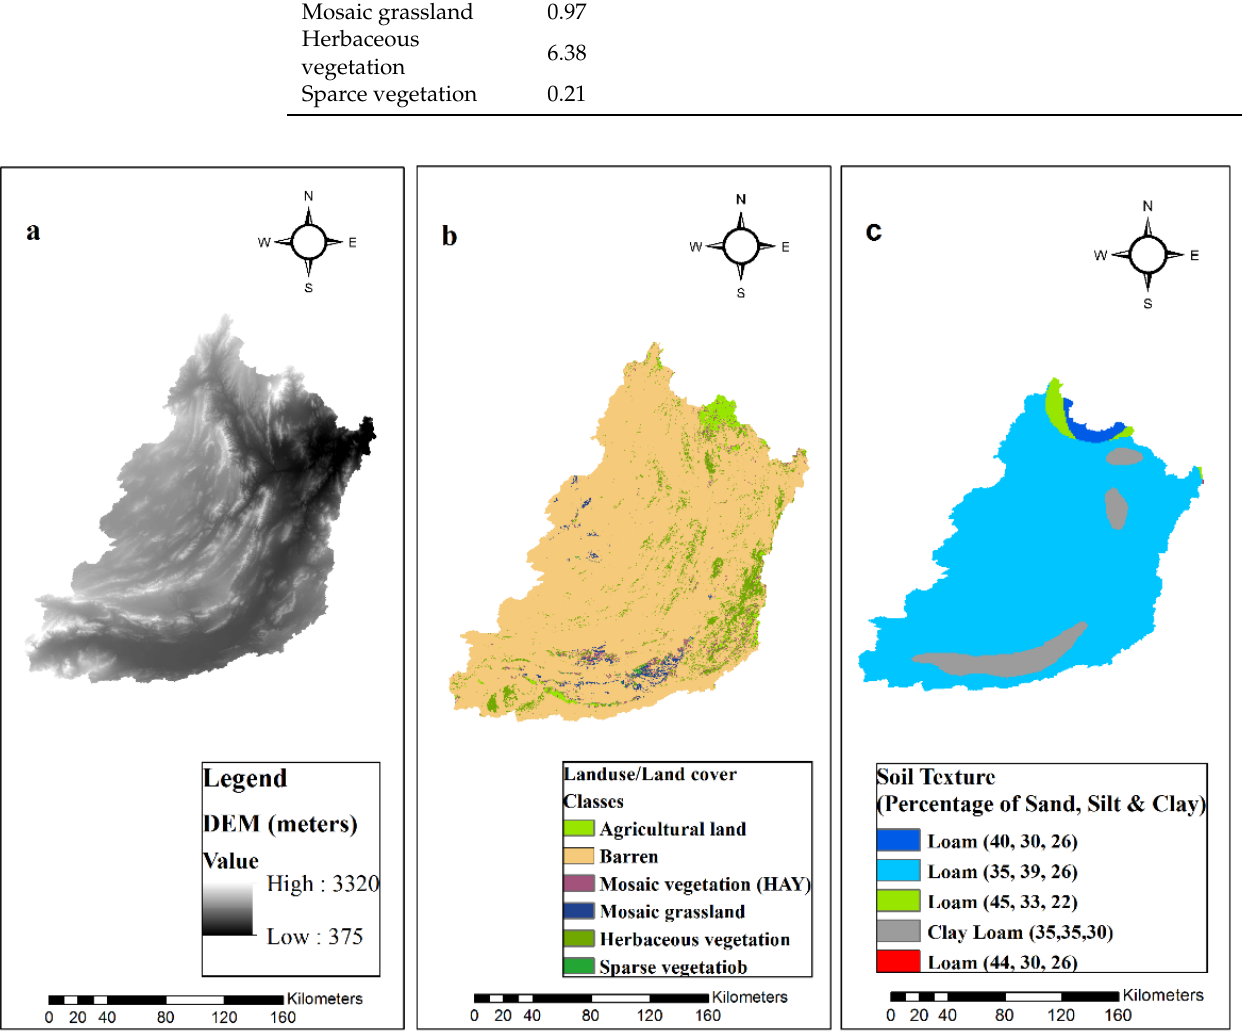
Figure 2. Spatial data inputs: ( a ) DEM, ( b ) land use land cover, ( c ) soil texture classes (percentages of silt sand and clay are given in parentheses). Table 2. Slope distribution in the Gomal River catchment.